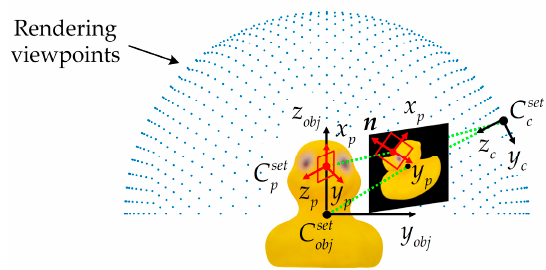
Figure 7. Coordinate systems used in the construction of the codebook.